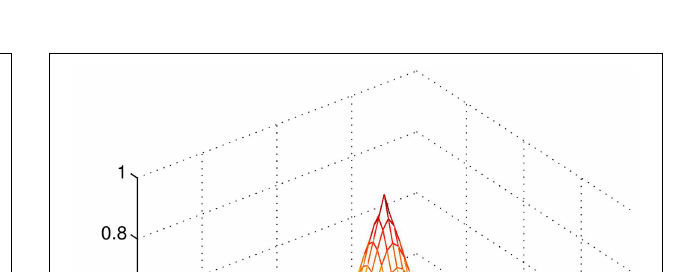
FIGURE 1 | Observation model block diagram.